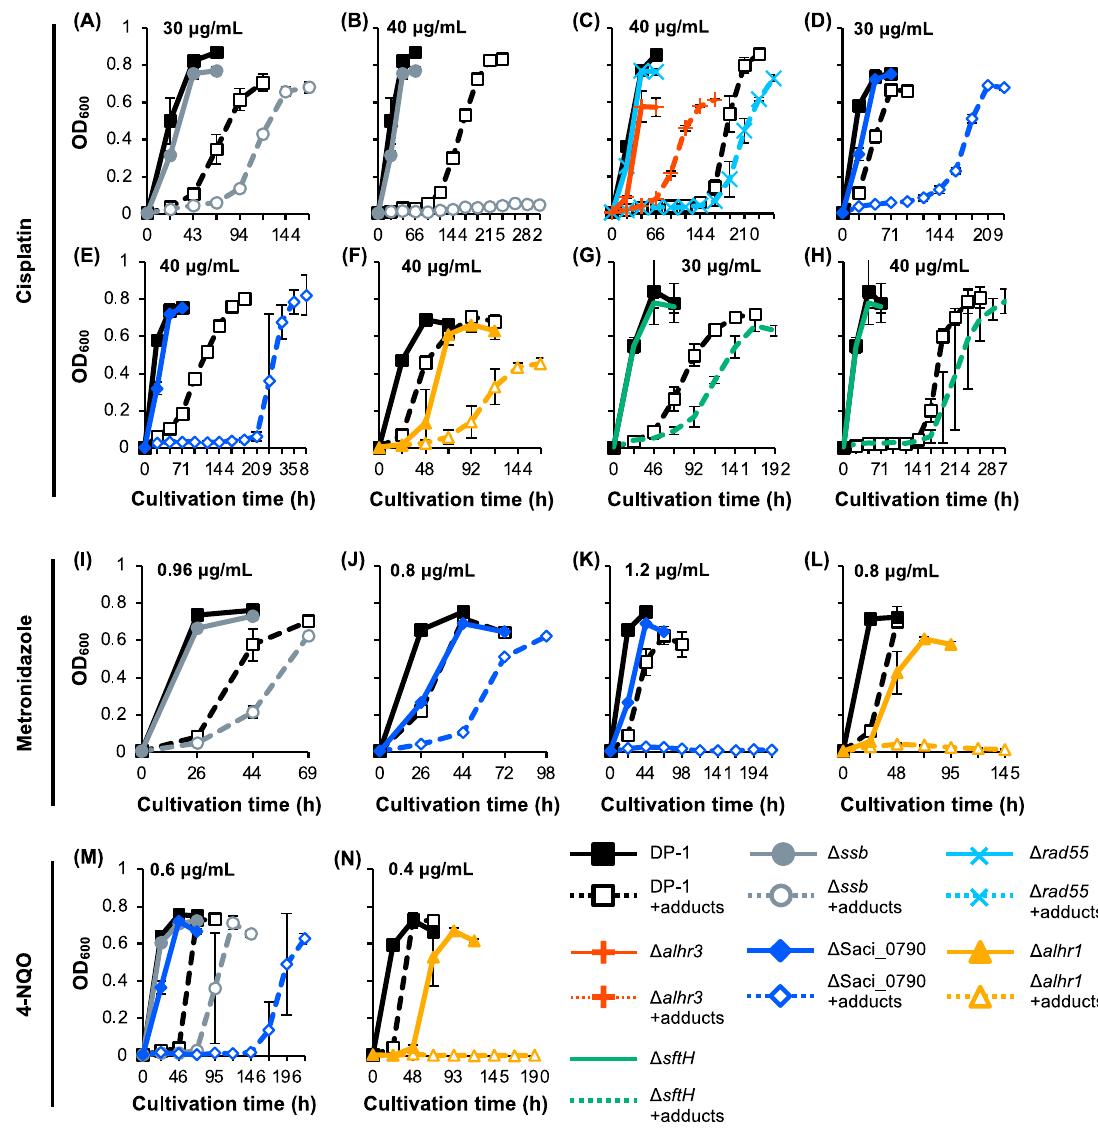
Figure 5. Growth curve of the knockout strains in the presence of DNA adducts. Each overnight culture of DP-1 (parent strain), Δ ssb , Δ rad55 , Δ alhr3 , Δ Saci_0790, Δ alhr1 , and Δ sftH was inoculated in liquid medium in the presence of cisplatin ( A – H ) (30 ( A , D , G ) and 40 μ g/mL ( B , C , E , F , H )) metronidazole at ( I – L ) 0.8 ( J , L ), 0.96 ( I ), and 1.2 mg/mL ( K )), and 4-NQO ( M , N ) (0.4 ( N ) and 0.6 μ g/mL ( M )), respectively, before being cultivated at 75 °C with shaking. Growth curves of Δ ssb ( A , B , I , M ), Δ rad55 and Δ alhr3 ( C ), Δ Saci_0790 ( D , E , J , K , M ), Δ alhr1 ( F , L , N ), and Δ sftH ( G , H ) are shown. Solid and dotted (+adducts) lines indicate growth curves in the absence or presence of DNA adducts, respectively. Error bars represent ±SD calculated using three biological replicates.